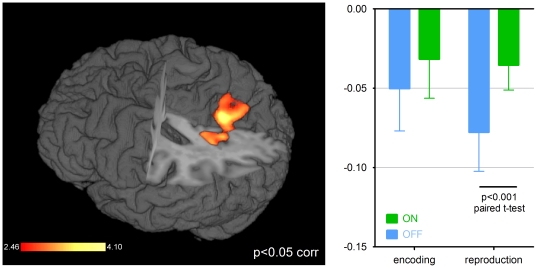
Area activated in the reproduction phase, ON>OFF.On the left, results of the second-level group analysis (p<0.05 corrected) are rendered to a structural MRI image using vlrender function from Lipsia package. On the right, the mean contrast estimate plots ± SD in the right precuneus (coordinates 4 −62 26) during encoding (left) and reproduction (right) phases. There was deactivation of the precuneus found in all four conditions (encoding ON, encoding OFF, reproduction ON, reproduction OFF). Comparison between OFF (blue) and ON (green) conditions was significant only during the reproduction phase (paired t-test, p<0.001), when deactivation was more marked in the OFF condition.